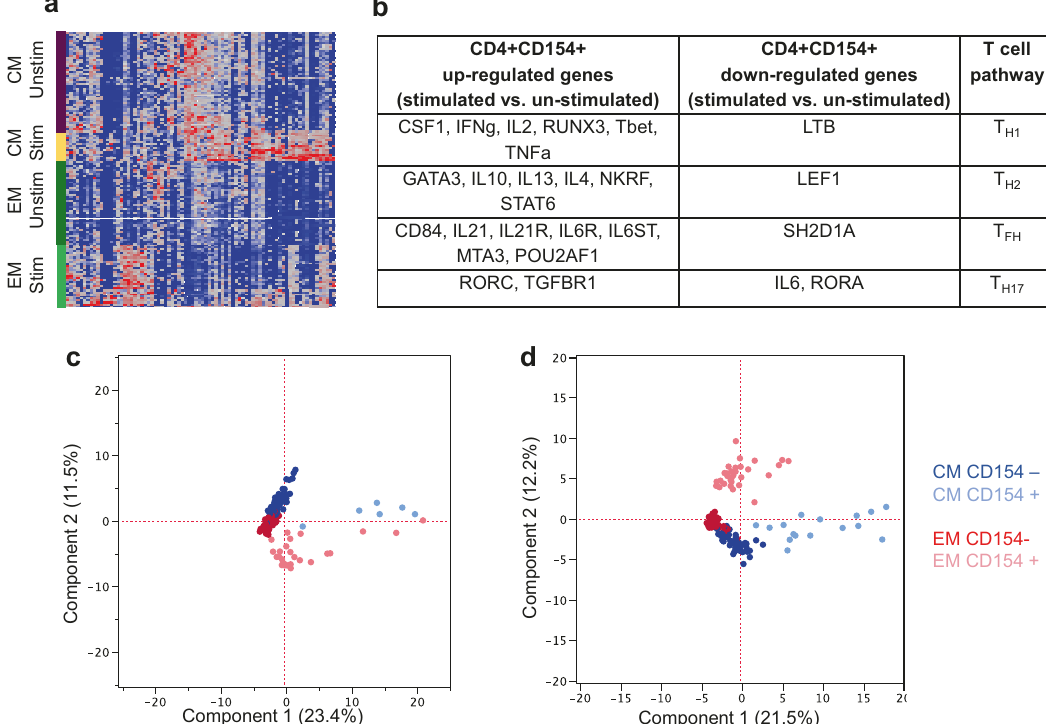
Fig. 3 Distinct gene expression pro fi le in post vaccination sorted antigen-speci fi c T EM and T CM populations. a Gene expression heat map identifying uniquely uregulated genes within T CM and T EM compartments for all 24 rhesus macaques (red indicates upregulation). b Gene expression pro fi le between 1086.C ENV peptide stimulated and unstimulated cells describing up- and downregulated genes of CD4 + CD154 + populations. c , d The SVM-RFE (Support Vector Machine with Recursive Feature Elimination) transcriptional pro fi ling is shown for T CM and T EM compartments based on expression of CD154 in c post prime and d post boost time points. Both T CM and T EM cells could be readily discriminated based on CD154